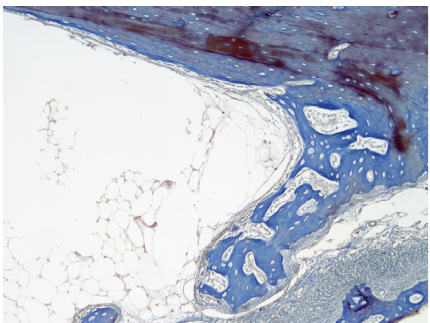
Figure 2: Cross section of the rabbit’s jaw 2 weeks after the for- mation of a bone defect and introduction of calcium hydroxide